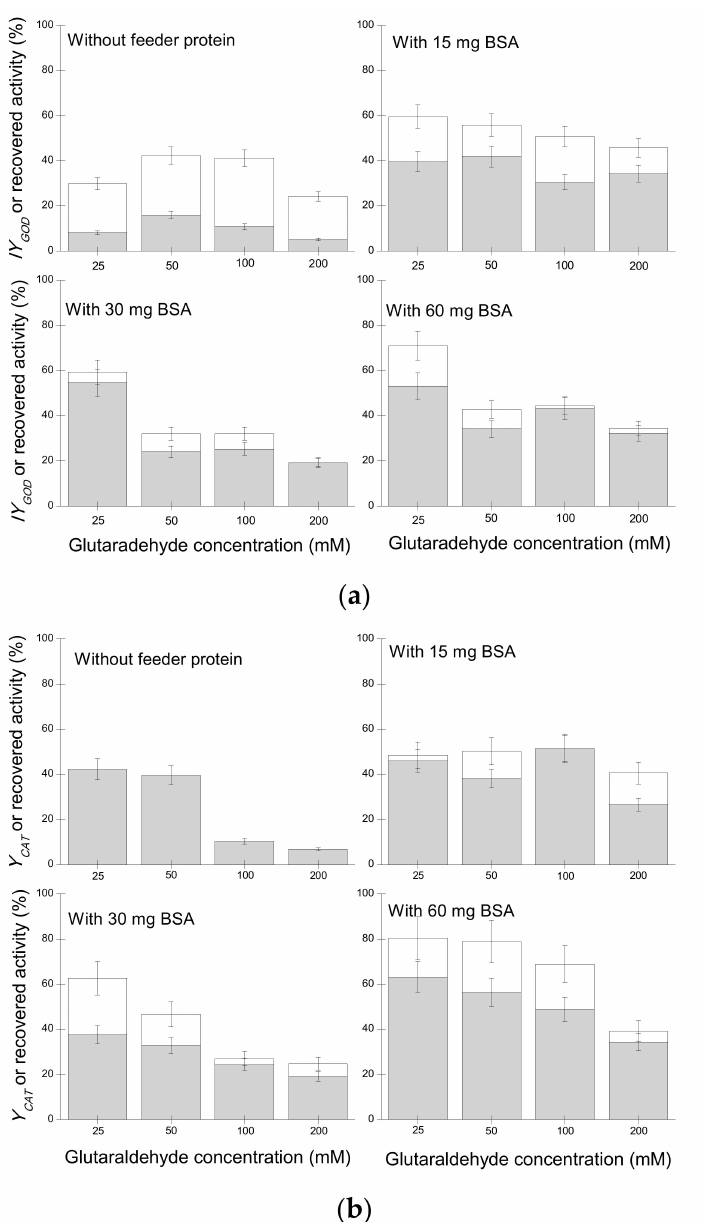
Figure 1. Immobilization yield of ( a ) GOD and ( b ) CAT in the combi- crosslinking of enzyme aggregates (CLEAs) in the presence and absence of bovine serum albumin (BSA) as feeder protein (white columns); recovered activities of the GOD in the combi-CLEAs after 5 h at 40 ◦ C and pH 6.0 (gray columns). Activities of both GOD and CAT in combi-CLEAs increased with increasing GLU concentration, − 1 with the maximum activity (505.9 ± 45.5 and 3806.6 ± 342.4 U mL , respectively) obtained at 50 mM GLU concentration, corresponding to 42.3 and 48.4% of the initial activities, respectively (Tables A1 and A2). For both enzymes, a further increase in the GLU concentration produces a decrease in the observed activity. This activity reduction could be attributed to an excessive enzyme modification